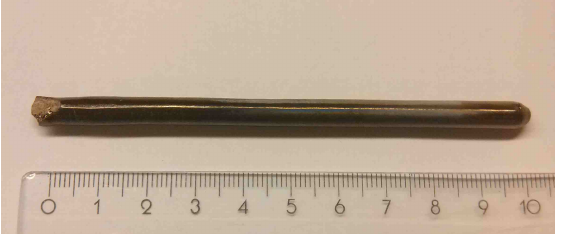
Figure 1. (Color online) A photo of the as-grown LaSrCoO 4 crystal. The last ∼ 6 cm (on the right side) are single crystalline—i.e., roughly the part starting from number 4 on the ruler to somewhat below number 10 where the growth was